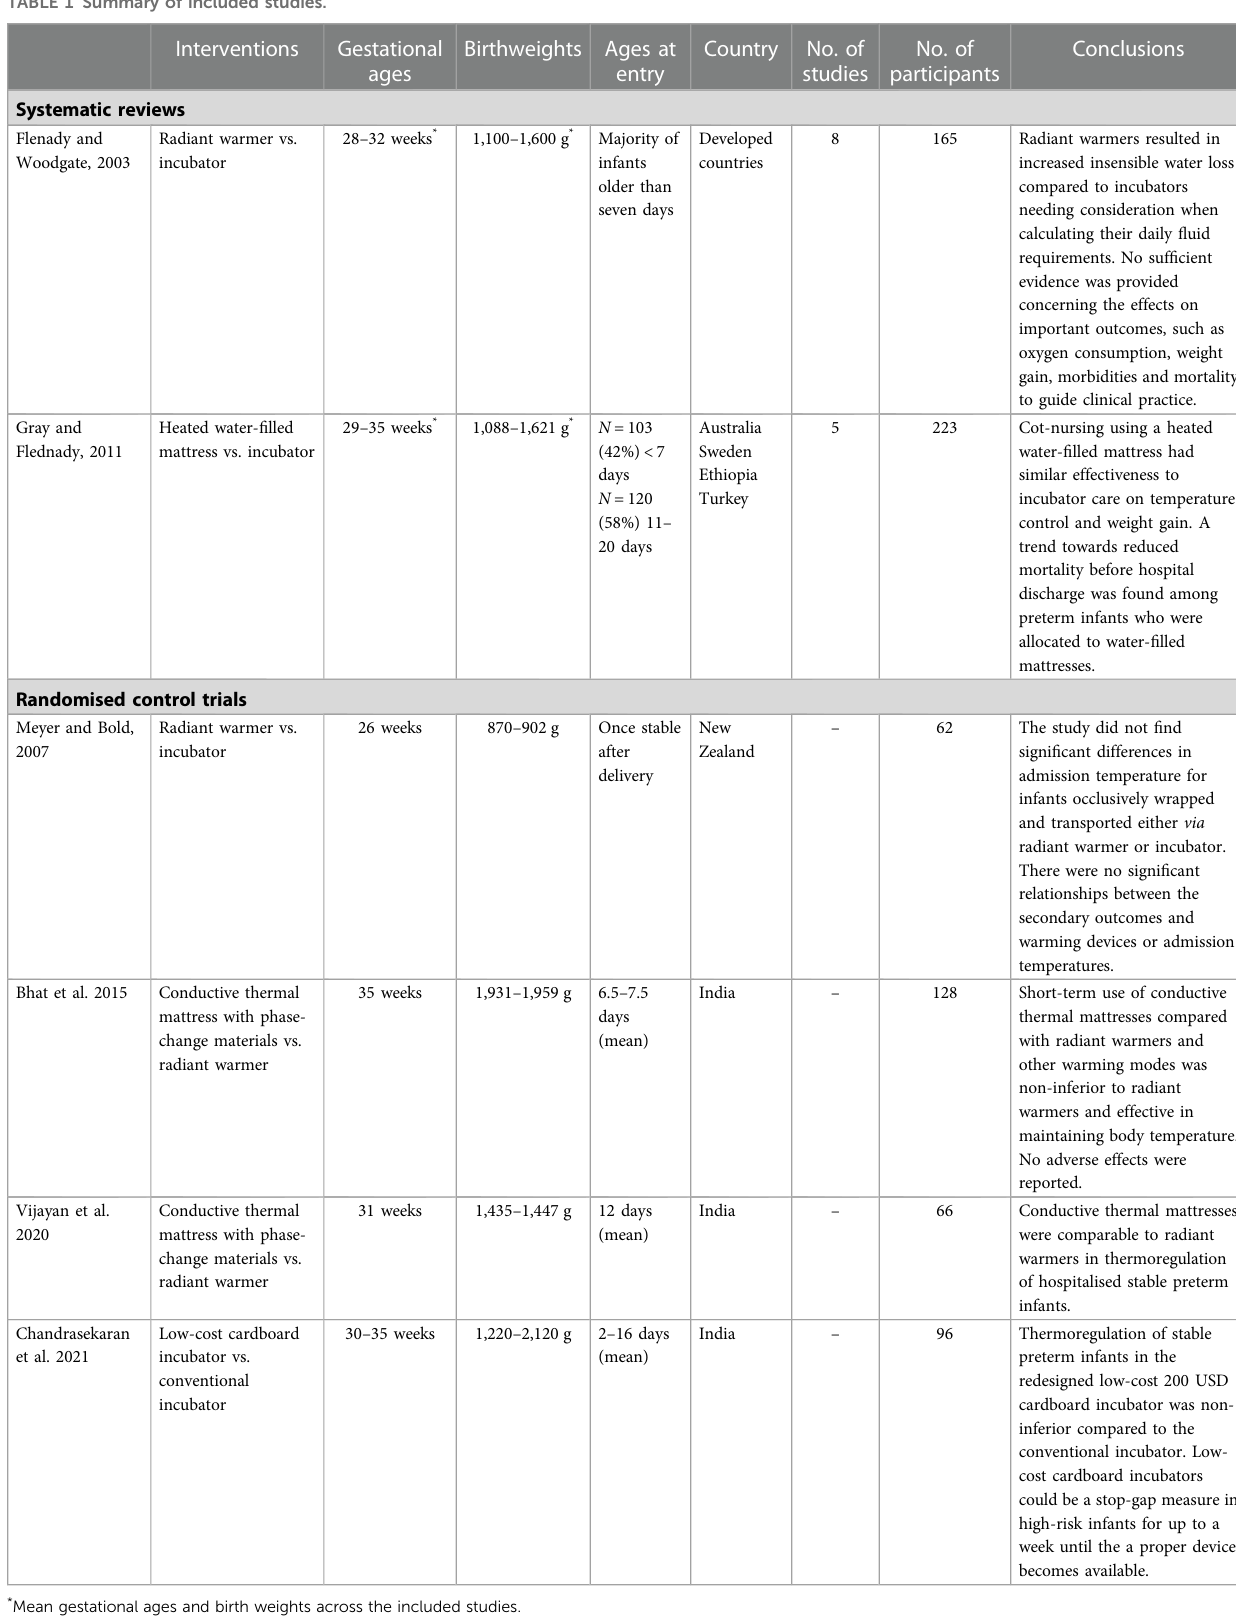
TABLE 1 Summary of included